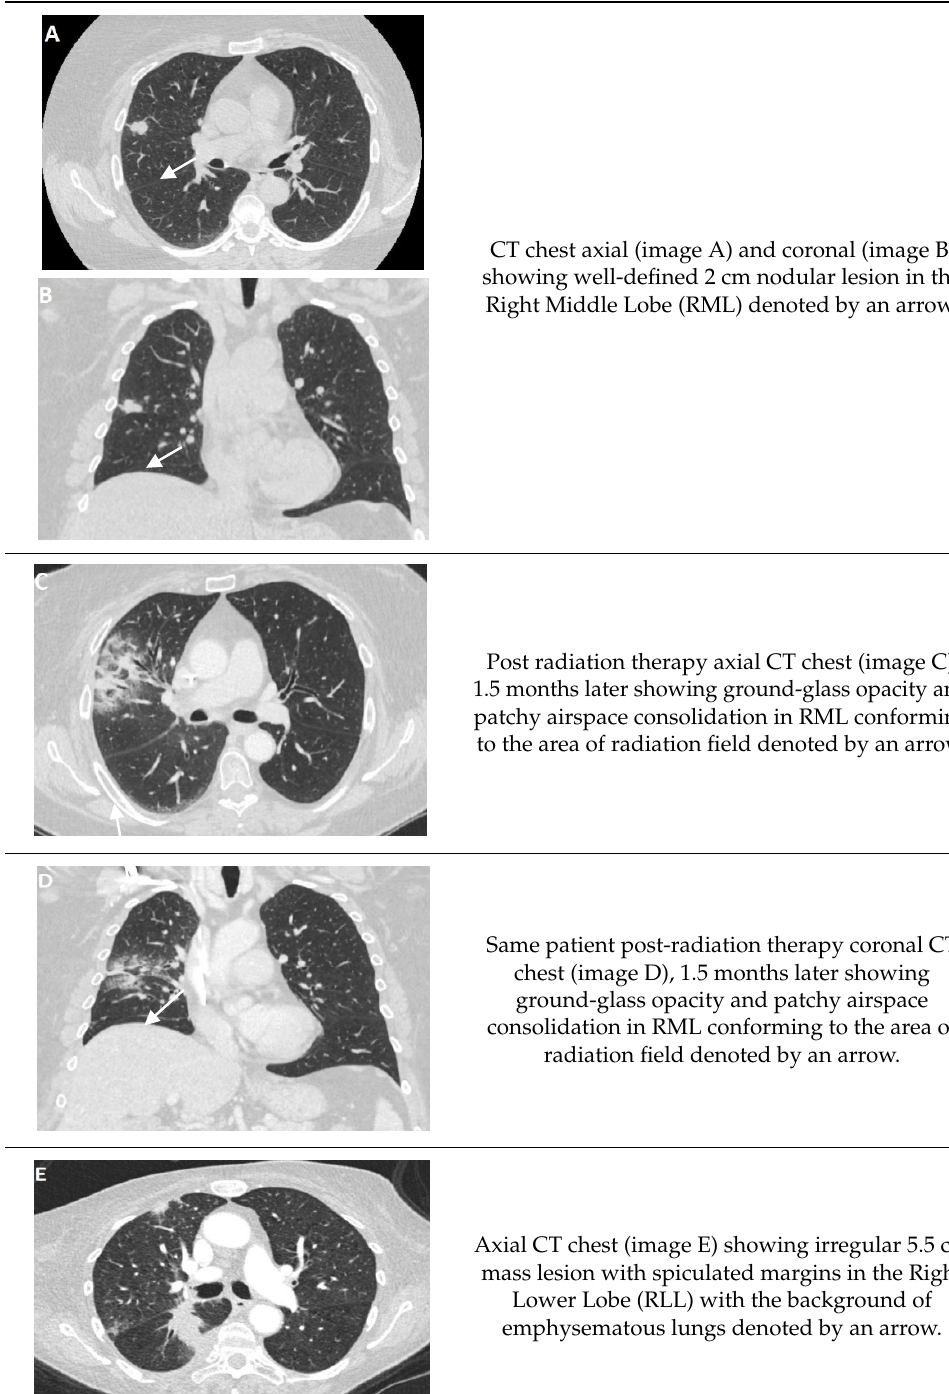
Table 3. Computed Tomography (CT) chest illustrating post-radiation therapy changes in the lungs.